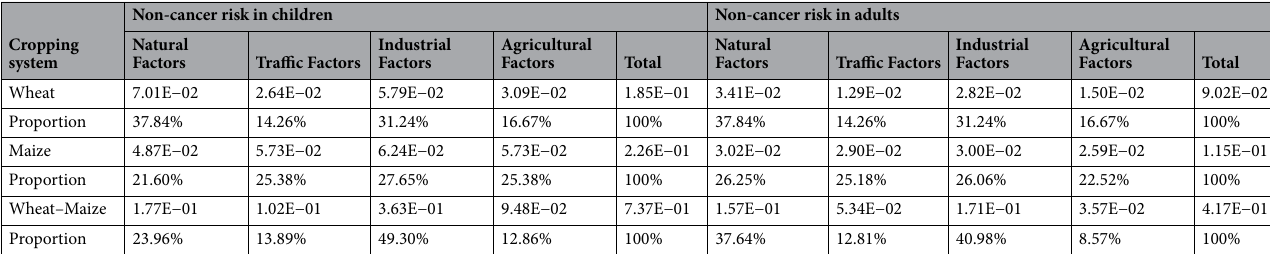
Table 4. Non-carcinogenic risks for wheat and maize cropping